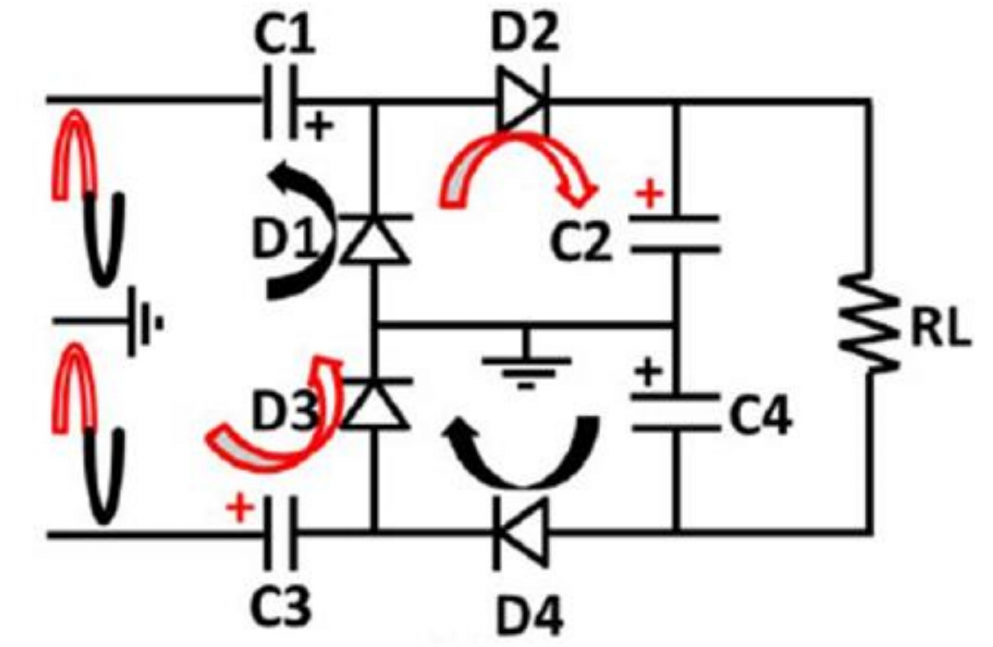
Figure 4. Greinacher rectifier configuration